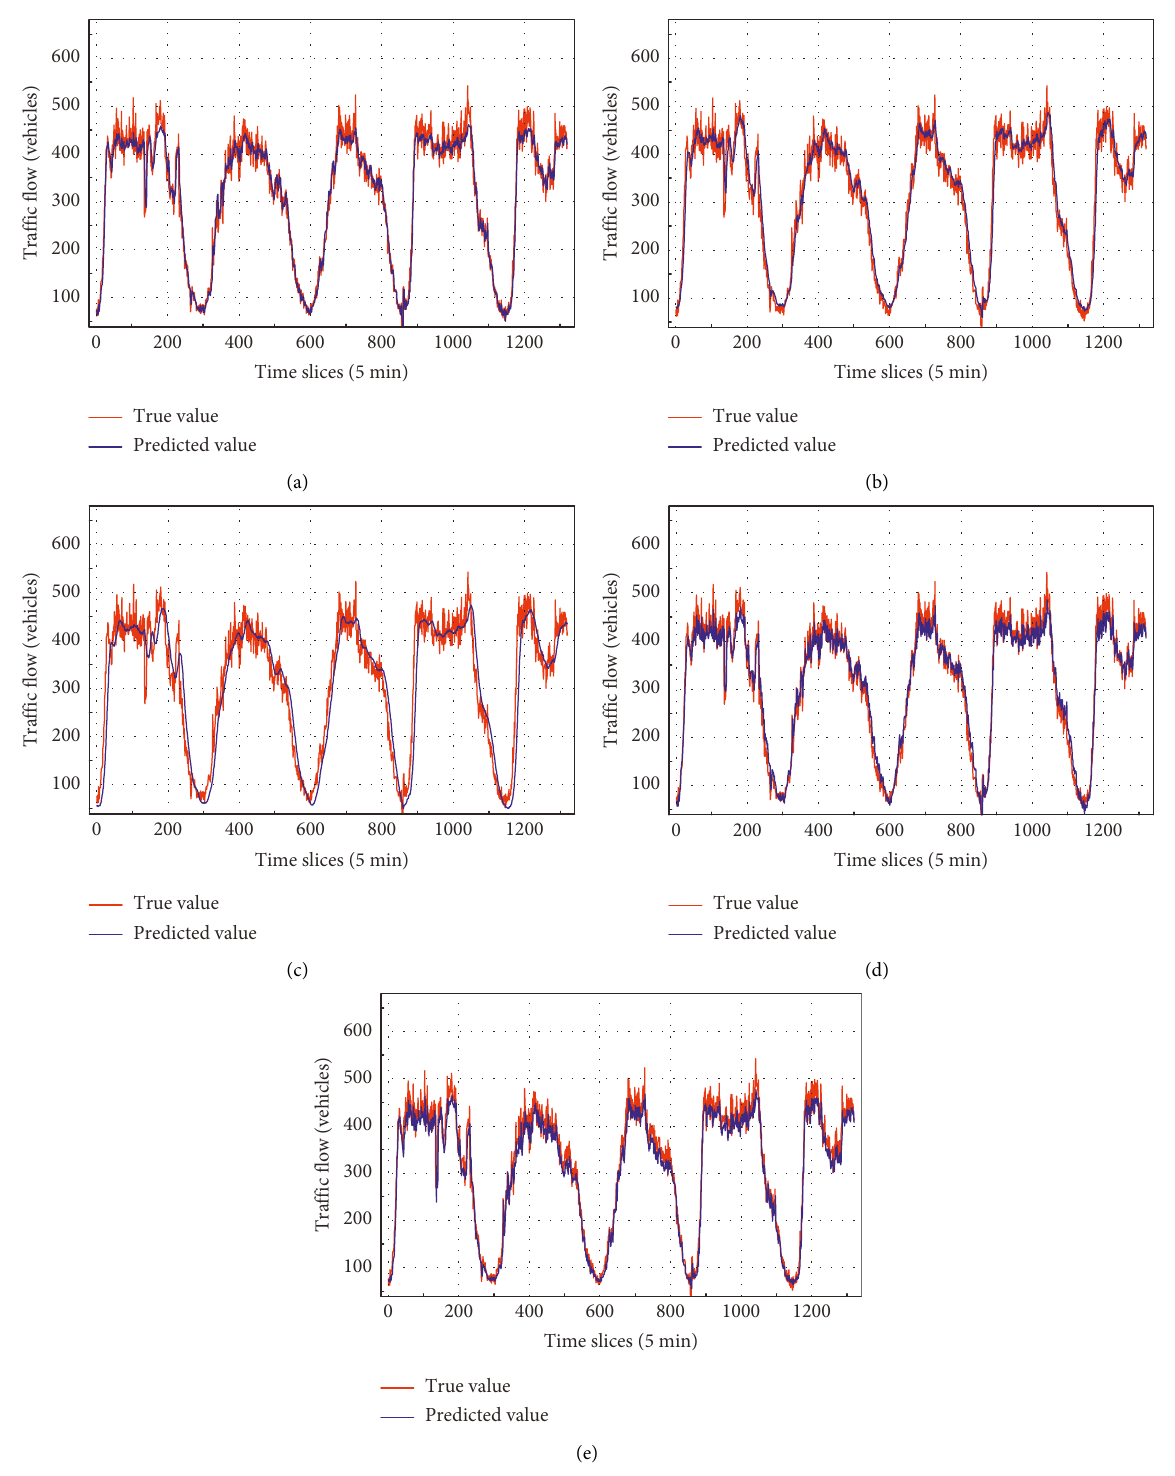
Figure 14: Prediction results of each model using the PeMSD8 dataset: (a) PDRGA-CDBN-LSTM; (b) CDBN-LSTM; (c) CDBN; (d) LSTM; and (e) PDRGA-CDBN-LSTM (noisy